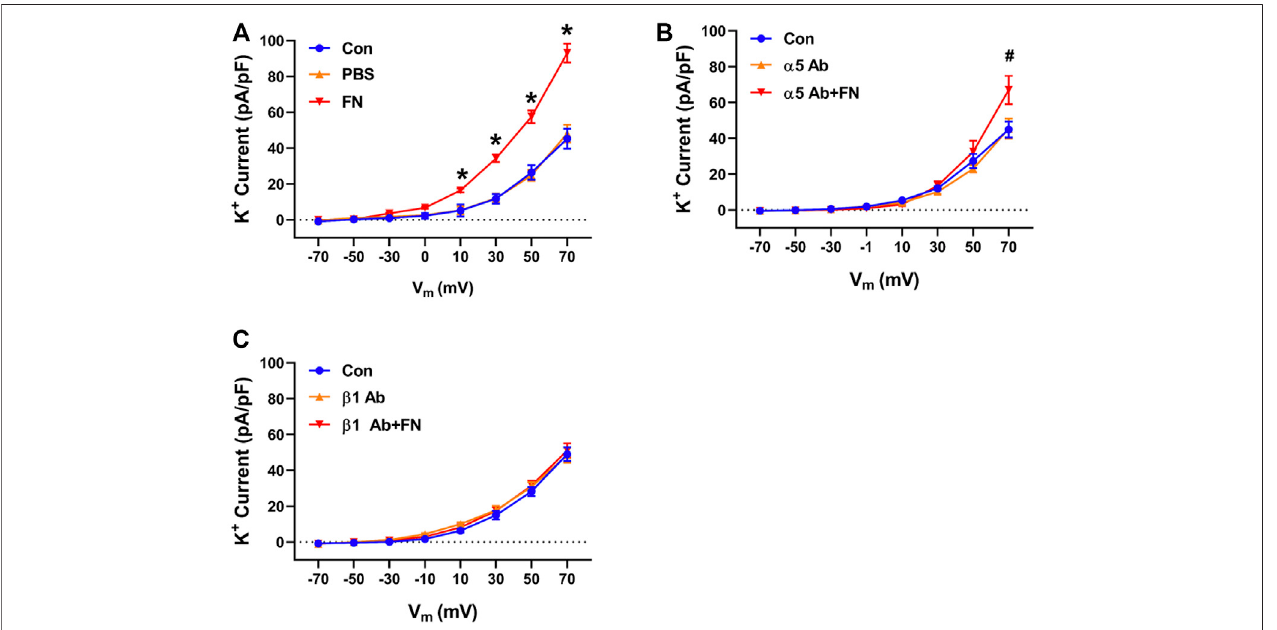
FIGURE 5 | A function blocking antibody (Ab) versus the integrin subunit α 5 or β 1 interferes with the stimulatory effect of native FN on K + currents of cerebral VSMCs. Panel (A) , current — voltage relationship under control/buffer (PBS) conditions. Panel (B) , current — voltage relationships in the presence of an α 5 integrin antibody alone and α 5 antibody plus FN. Panel (C) ,current — voltage relations in the presence ofa β 1integrin antibody alone and β 1antibodyplus FN; n =12 – 16cells in each group. Results are shown as mean ± SEM. * p < 0.05 control and PBS vs. FN; # p < 0.05 control and α 5 Ab vs. α 5 Ab + FN.